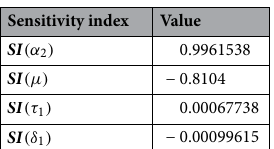
Table 4. Sensitivity indices of R eff ( m )